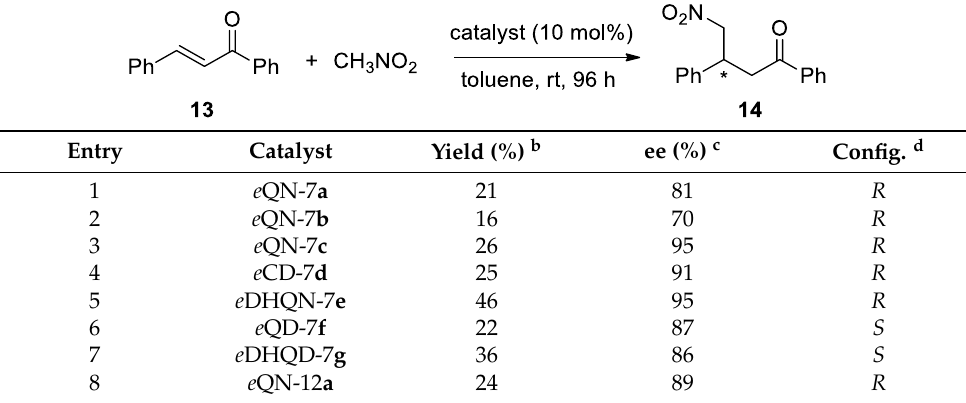
Table 1. Asymmetric Michael addition of nitromethane to trans -chalcone a .